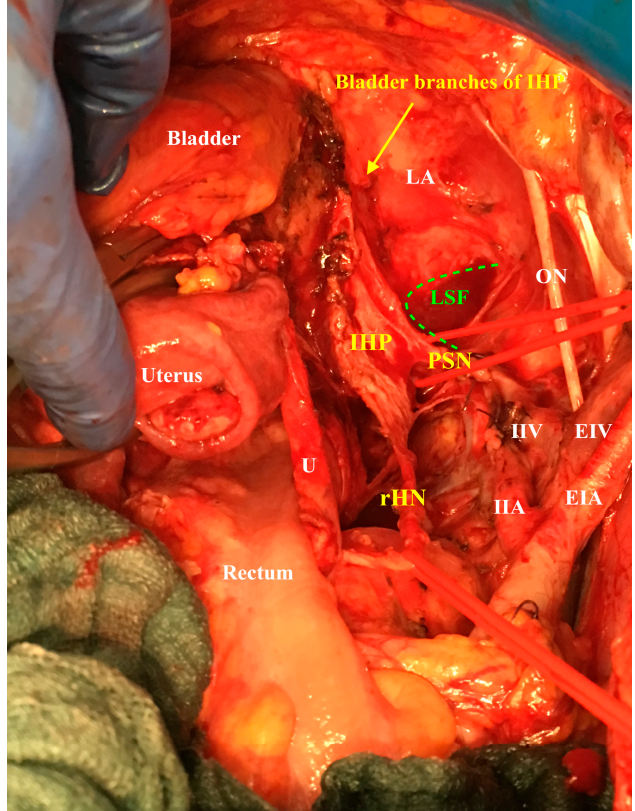
Figure 5. Cranial appearance of the right inferior hypogastric plexus during nerve-sparing radical hysterectomy. U: ureter, IIA: internal iliac artery, IIV internal iliac vein, EIA: external iliac artery, EIV: external iliac vein, ON, obturator nerve, IVV: inferior vesical vessels, PSN: pelvic splanchnic nerves, LSF: lesser sciatic foramen, LA: levator ani, IHP: inferior hypogastric plexus, rHN: right hypogastric nerve.